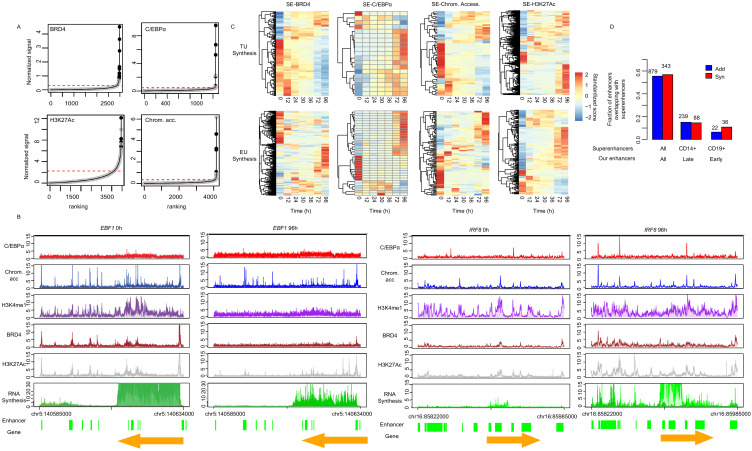
Synergistic enhancers drive cell type-specific genes.(A) ChIP signal for BRD4, C/EBPα, and H3K27Ac, and ATAC-seq signal, ranked by signal strength on the peaks within 1 kb of our enhancers (Materials and methods, black dots) with cutoff value for superenhancers (red dashed line). Additive enhancers are shown with gray dots. (B) Coverage tracks of exemplary superenhancers, EBF1 and IRF8 at 0 hr and 96 hr. H3K27Ac at 72 hr instead of 96 hr is depicted. (C) Heatmap of RNA synthesis on target genes (upper panel) or eRNAs (lower panel) of superenhancers determined by ChIP occupancy with BRD4 or C/EBPα, H3K27Ac, and chromatin accessibility. (D) Fraction of our additive (blue) or synergistic (red) enhancers overlapping with superenhancers from dbSUPER (Hnisz et al., 2013; Khan and Zhang, 2016). All of our additive or synergistic enhancers (136 enhancers) were compared with superenhancers from all available cells in dbSUPER (first column), from CD14+ cells, which are macrophage cells (second column), and from CD19+ cells, which are B cells (third column). Fisher’s exact test p-value is shown.